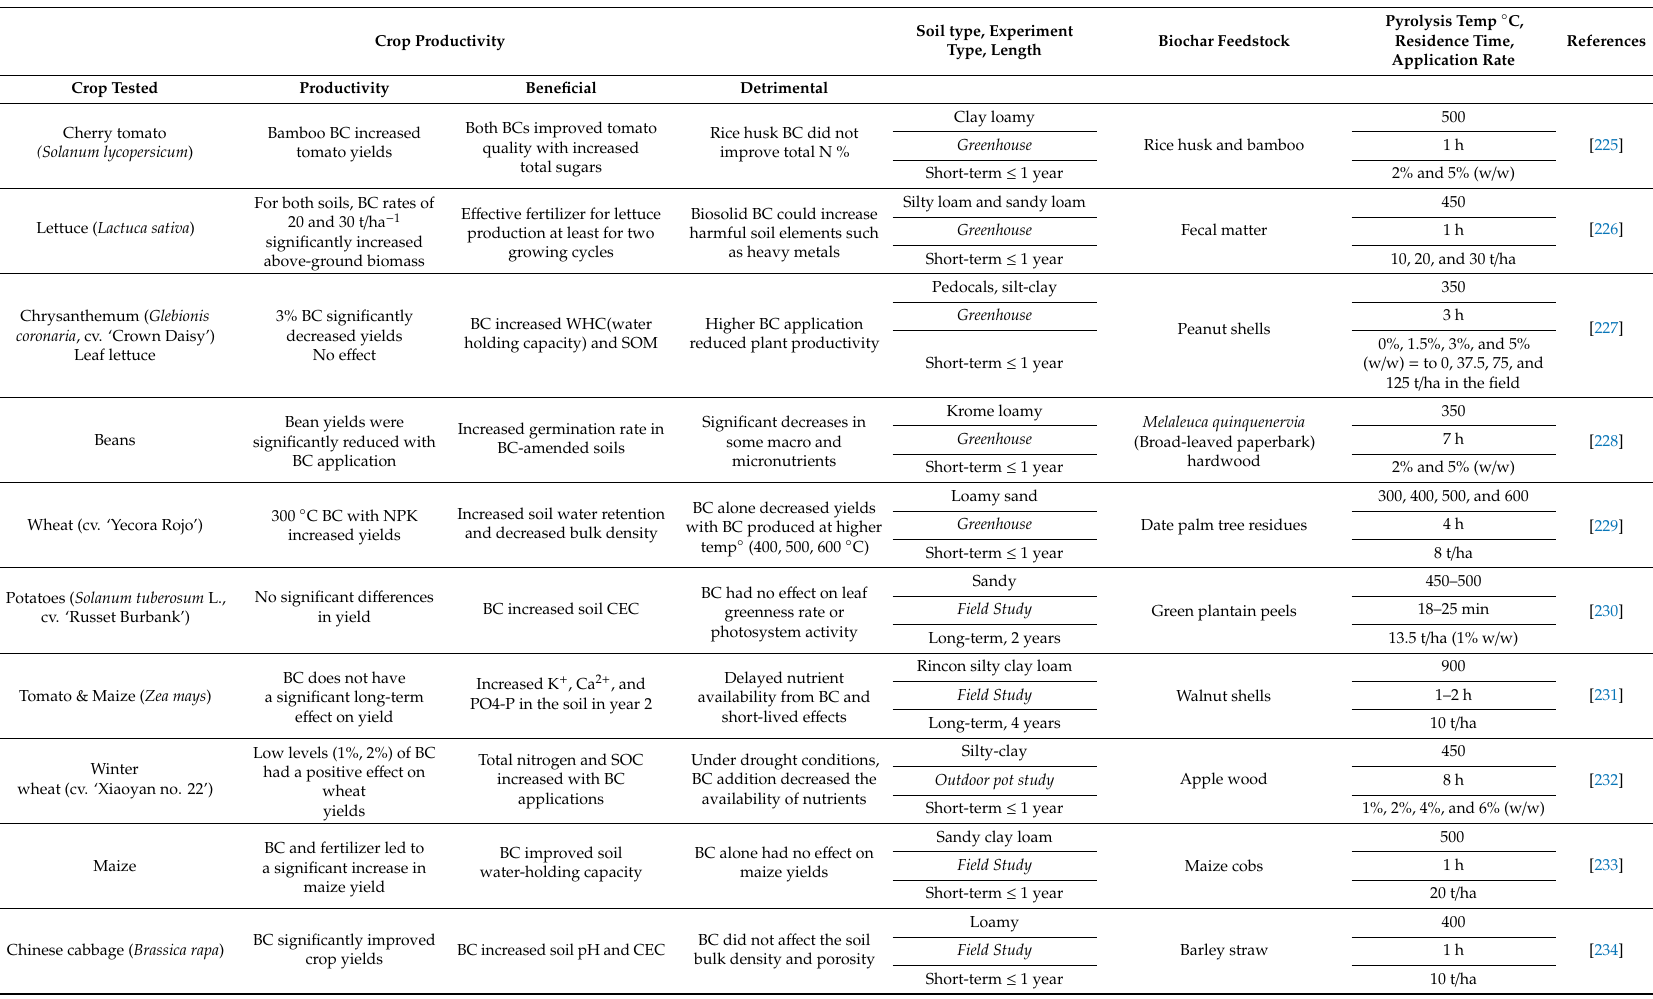
Table 6. Impact of BC on crop productivity summarized from a comprehensive literature search. Soil types listed in the table correspond to the types reported in the original studies. CEC: cation exchange